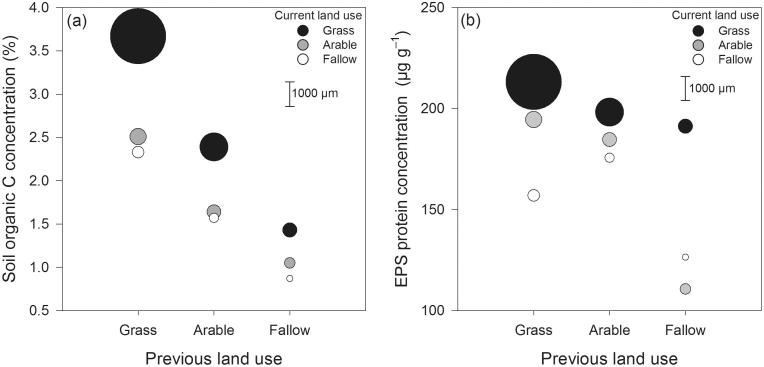
Mean (n = 3) (a) soil organic C concentration (y-axis), and (b) EPS-protein concentration as related to stable aggregate mean weight diameter (MWD; circles) for the nine previous × current land use combinations. Previous land use (x-axis) is shown in factorial combination with current grass, arable and fallow land uses (black, grey and white symbols, respectively). The diameter of each circle represents the stability (scale bar at 1000 µm MWD).